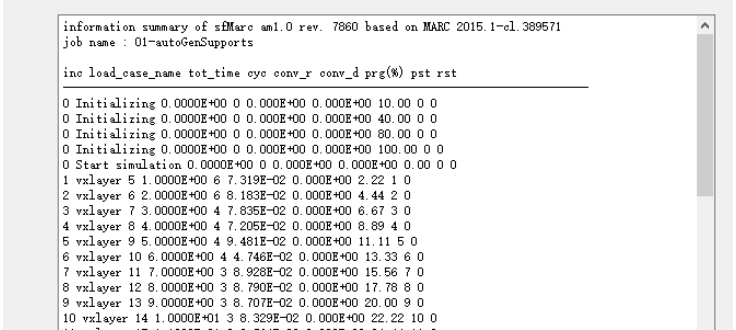
Fig. 9 QT reads the middle data of the status